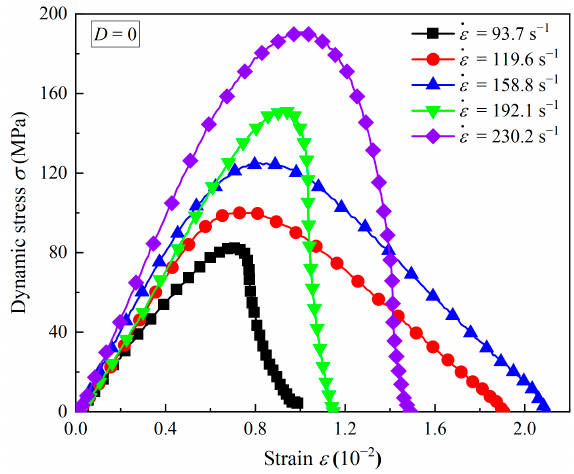
10 of 25 Figure 12. TESCAN VEGA3 scanning electron microscopy (SEM) test system. 3. Results and Discussion 3.1. Dynamic Properties of Coal Measures Sandstone In this study, five similar high strain rates are obtained by setting five different im- pact pressures to investigate the dynamic mechanical properties of coal measures sand- stone under impact loading conditions. Figure 13 illustrates the impacts of the strain rate on the stress–strain curves of the sandstone specimens without accumulated damage. The stress–strain curves with high strain rates show certain similarities, which means they can all be roughly classified into three phases. The first phase is the linear elastic phase, in which the dynamic stress–strain curves exhibit a straight upward tendency. In this phase, the stress wave propagated from the incident bar into the sandstone specimen will prop- agate many times inside the specimen and, finally, the strain and stress will reach a uni- form state. The second phase is the plastic deformation phase, which begins at the end of the linear elastic phase and ends when the stress of the specimen reaches the peak value.